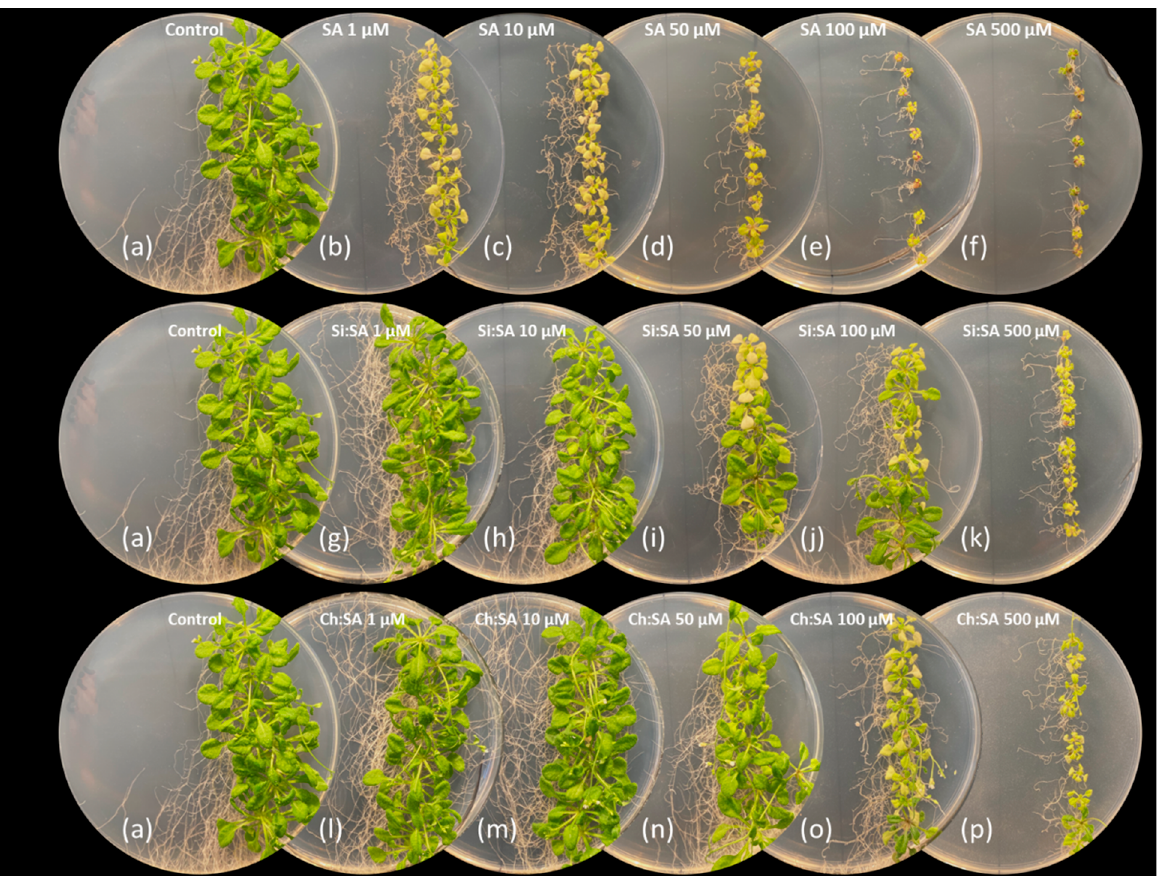
Figure 6. Effect of free SA, Si:SA and Ch:SA on plant performance in Col-0 Arabidopsis plants. Five-day-old plants were transferred to media containing the different SA treatments and pictures were taken 28 days later.